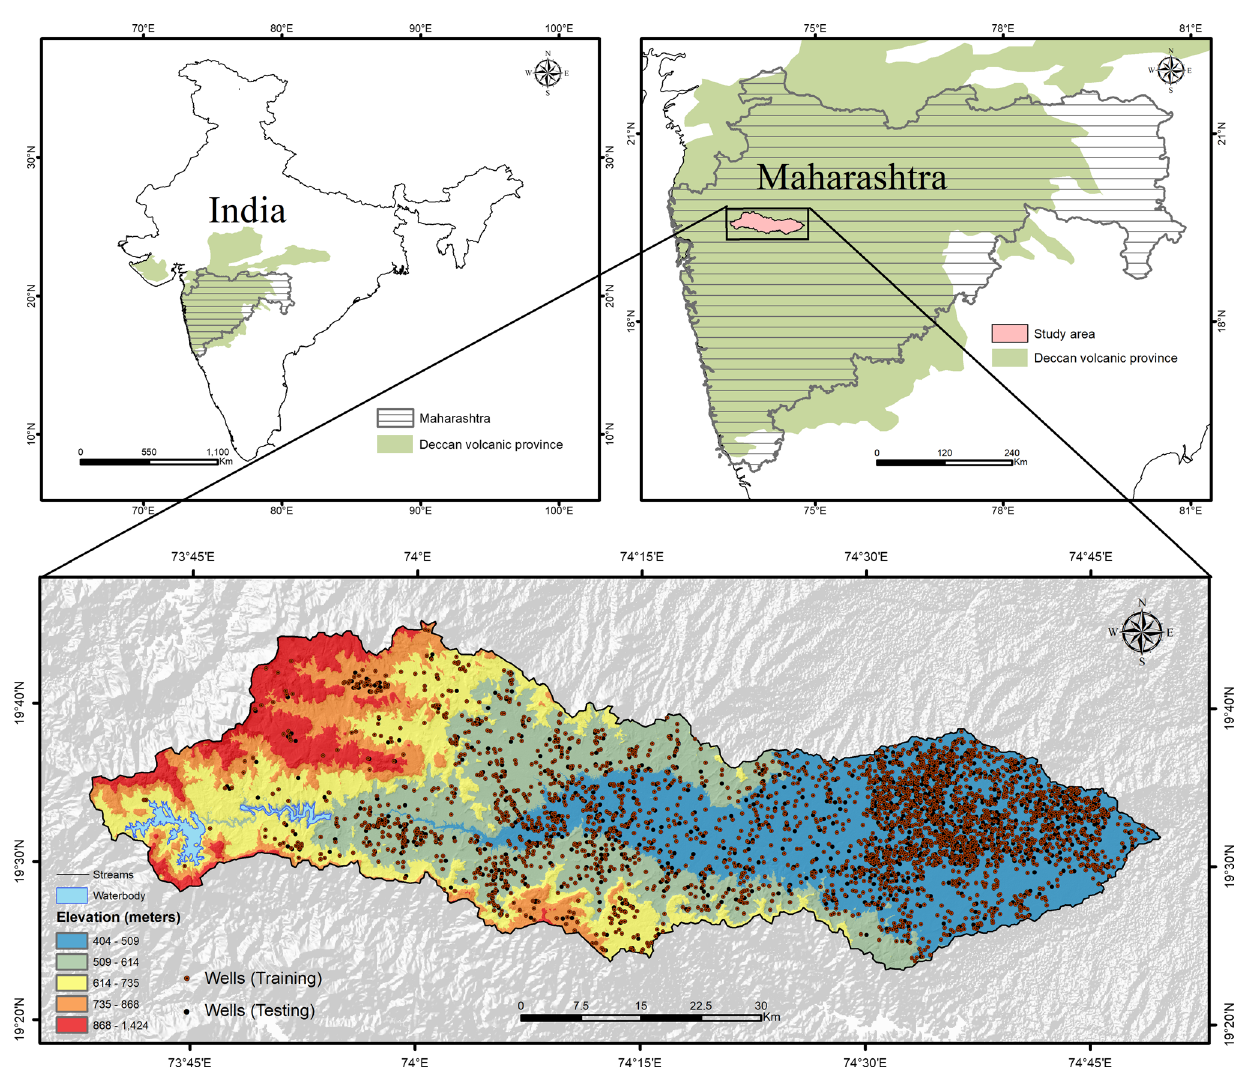
Fig. 1 Location map of the study area with reference to Maharashtra State and India. The inset green layer is representing the Deccan Volcanic Province which is one of the greatest geological formations in